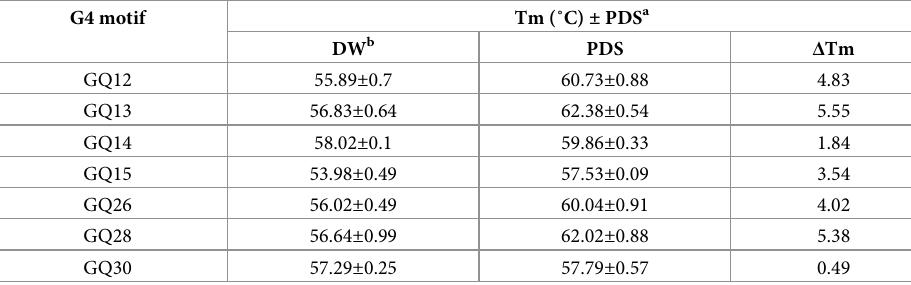
Table 1. Effect of PDS on the Tm values of ORF14